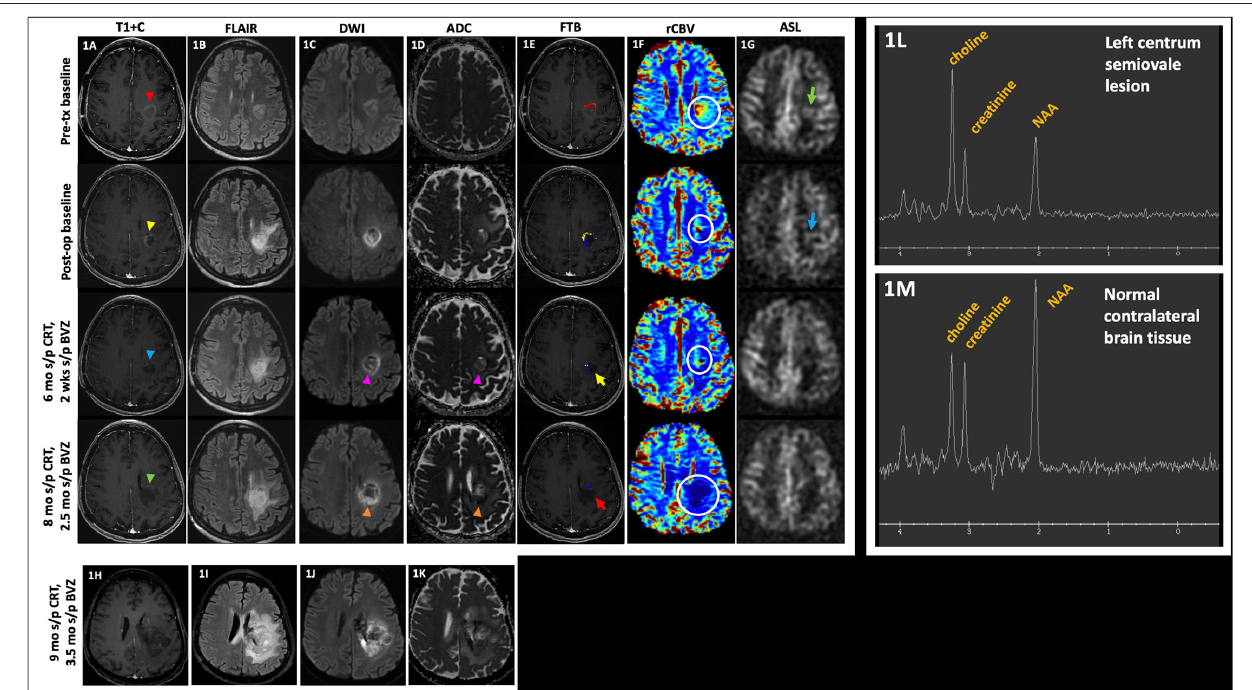
FIGURE 1 | Pseudoresponse. A 57 year-old female with anaplastic astrocytoma (IDH wt, MGMT-) initially demonstrated a mildly enhancing left posterior frontal lobe mass [ (A) , top row, red arrowhead], with FLAIR hyperintensity [ (B) , top row], mild diffusion restriction [ (C,D) , top row], small area of high fractional tumor burden (FTB high ) at the anterior aspect of the lesion [ (E) , top row], increased rCBV [ (F) , top row, white circle], and ASL hyperperfusion [ (G) , top row, green arrow]. After resection, there is mild residual enhancement at the anteromedial aspect of the lesion [ (A) , 2nd row, yellow arrowhead] with increased perilesional FLAIR hyperintensity [ (B) , 2nd row], increased diffusion restriction [ (C,D) , 2nd row], decreased area of FTB high at the anterior aspect of the lesion [ (E) , 2nd row], decreased rCBV [ (F) , 2nd row, white circle], and mild ASL hyperperfusion [ (G) , 2nd row, blue arrow]. The patient was then initiated on BVZ. At 6 mo s/p CRT and 2 wks s/p BVZ, there is decreased enhancement [ (A) , 3rd row, blue arrowhead], mildly decreased but persistent FLAIR hyperintensity [ (B) , 3rd row], decreased diffusion restriction [ (C,D) , 3rd row, pink arrowheads], decreased area of high fractional tumor burden (FTB high ) [ (E) , 3rd row, yellow arrow], mildly decreased rCBV [ (F) , 3rd row, white circle], and no substantial ASL hyperperfusion [ (G) , 3rd row]. At 8 mo s/p CRT and 2.5 mo s/p BVZ, there is enlargement of the hypoenhancing lesion [ (A) , 4th row, green arrowhead] with increased perilesional FLAIR hyperintensity [ (B) , 4th row], and increased diffusion restriction [ (C,D) , 4th row, orange arrowheads]; however, there is persistently low FTB high [ (E) , 4th row, red arrow] and rCBV [ (F) , 4th row, white circle], likely due to normalization of tumor blood vessels and perfusion in the setting of BVZ. After BVZ was initiated, enhancement decreased with diffusion restriction although the FLAIR hyperintensity persisted. Subsequent outside hospital MR 9 mo s/p CRT showed increased hypoenhancing tumor (H) with markedly increased FLAIR hyperintensity (I) and diffusion restriction (J,K) . These findings are compatible with pseudoresponse (i.e., progressive infiltrative pattern of non-enhancing tumor) that is seen after BVZ therapy. Of note, MRS performed on her baseline pre-tx study showed the classic MRS glioma profile of increased choline, decreased creatinine, and decreased NAA peaks (L) when compared to the contralateral normal brain tissue (M) . MRS was not performed on subsequent follow-up studies. ADC, apparent diffusion coefficient; ASL, arterial spin labeling; BVZ, bevacizumab; CRT, chemoradiotherapy; FLAIR, fluid-attenuated inversion recovery; FTB, fractional tumor burden; IDH, isocitrate dehydrogenase; K trans , volume transfer coefficient; MGMT, O-6-methylguanine-DNA methyltransferase; mo, months; MRS, MR spectroscopy; op, operative; rCBV, relative cerebral blood volume; s/p, status post; T1 + C, post-contrast T1-weighted images; tx, treatment; wks, weeks; wt,